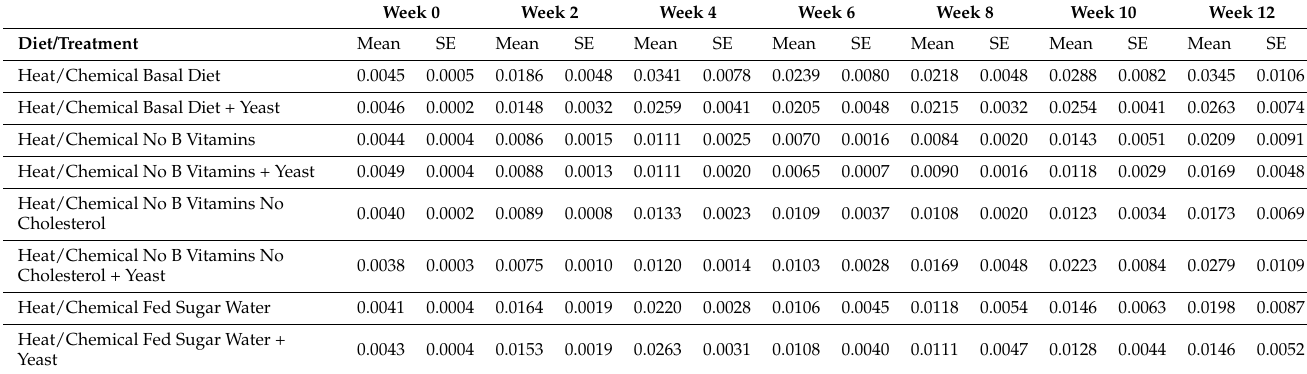
Figure 2. Average ( n = 8) brood weights over 12 weeks for small worker colonies of C. vicinus defaunated using a two-step heat and chemical process and then fed chemically defined diets with some nutrients deleted and the same diets augmented with a yeast associate. Table 3. Average brood weights and standard errors at 2 week intervals over 12 weeks for small worker colonies of C. vicinus defaunated using a two-step heat and chemical defaunation process and then fed chemically defined diets with some nutrients deleted and the same diets augmented with a yeast associate (this is table included because standard error bars are not discernable in Figure 2).